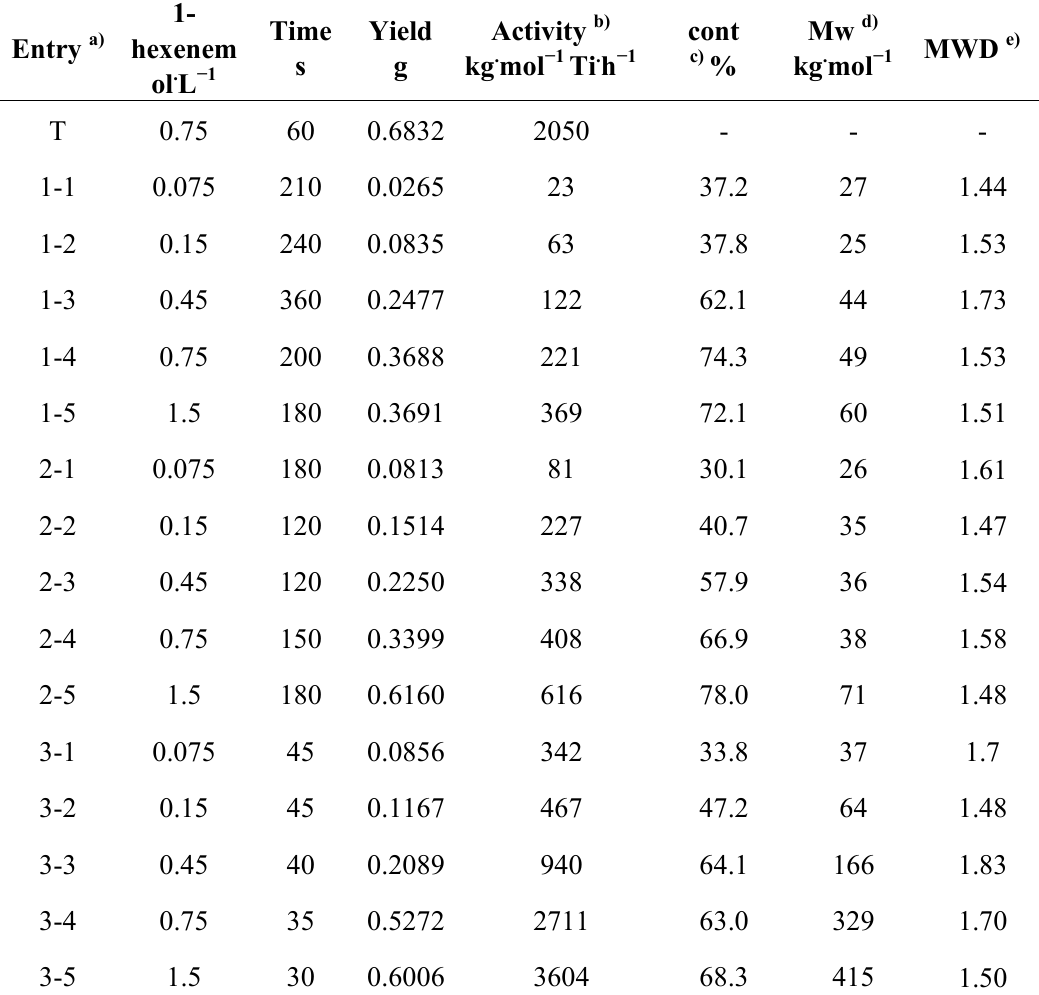
Table 1. Summary of ethylene/1-hexene copolymerization catalytic activities and properties of